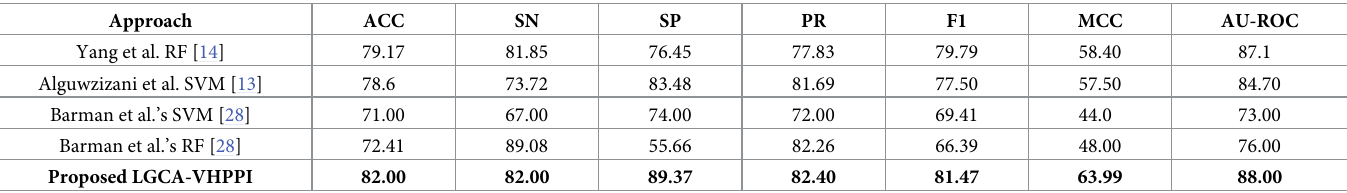
Table 3. Performance comparison of proposed LGCA-VHPPI with existing viral-host PPI predictors over a benchmark Barman dataset in terms of 7 different eval- uation measures. Performance figures of Barman et al. SVM [28], Barman et al. RF [28], Alguwzizani et al SVM. [13], and Yang et al. RF [14] are taken from Yang et al. [14]